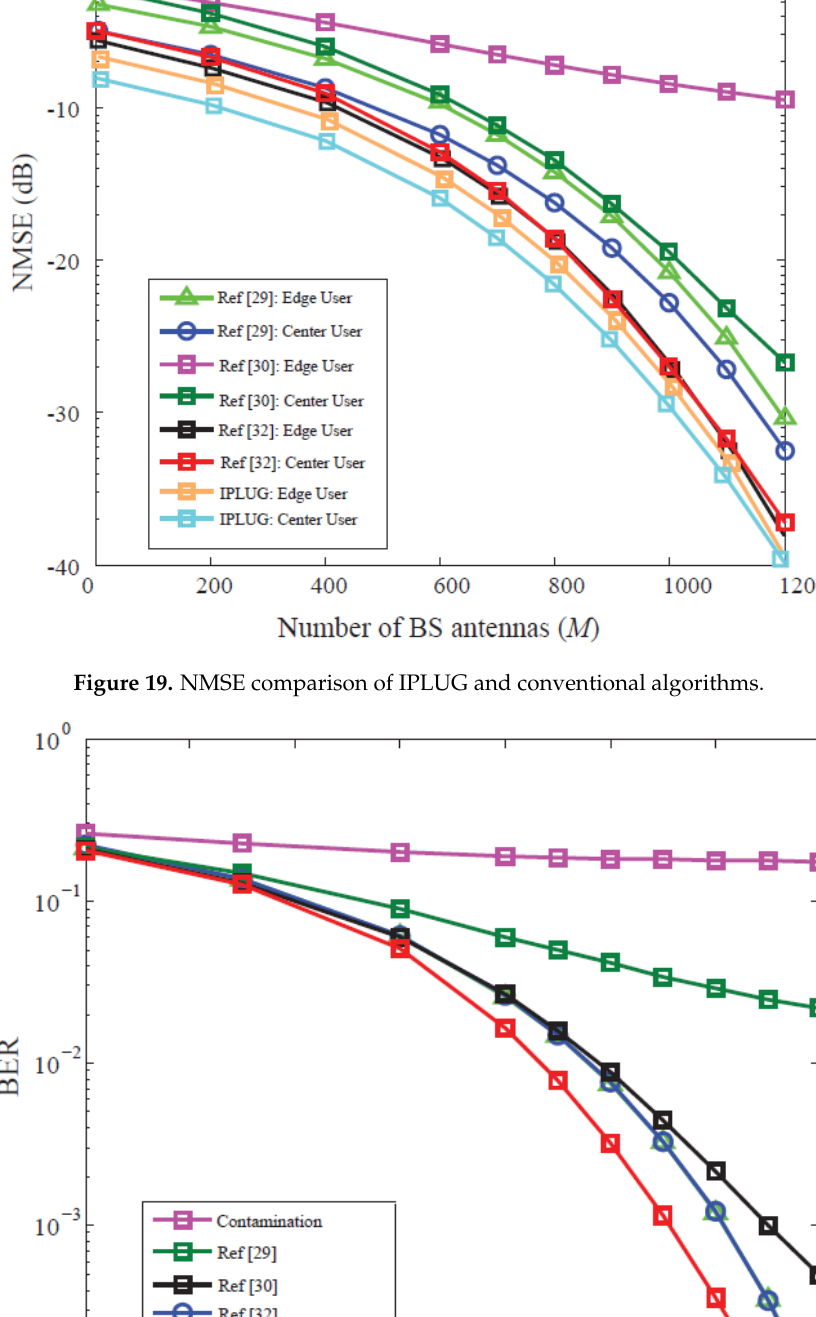
Figure 18. BER comparison against the number of cell users for the proposed pseudo-random pilot design and other cases.